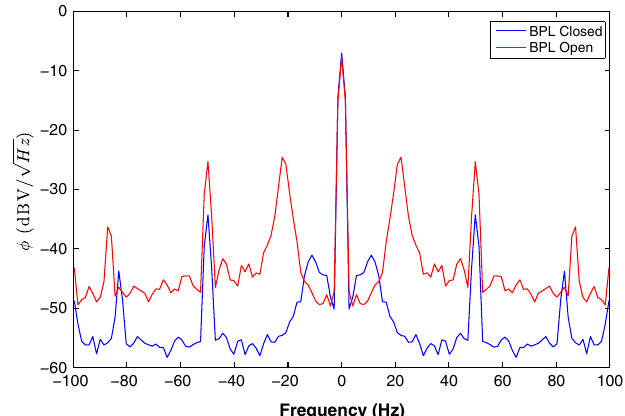
FIG. 2. Beam 1 phase error with beam phase loop open/closed.